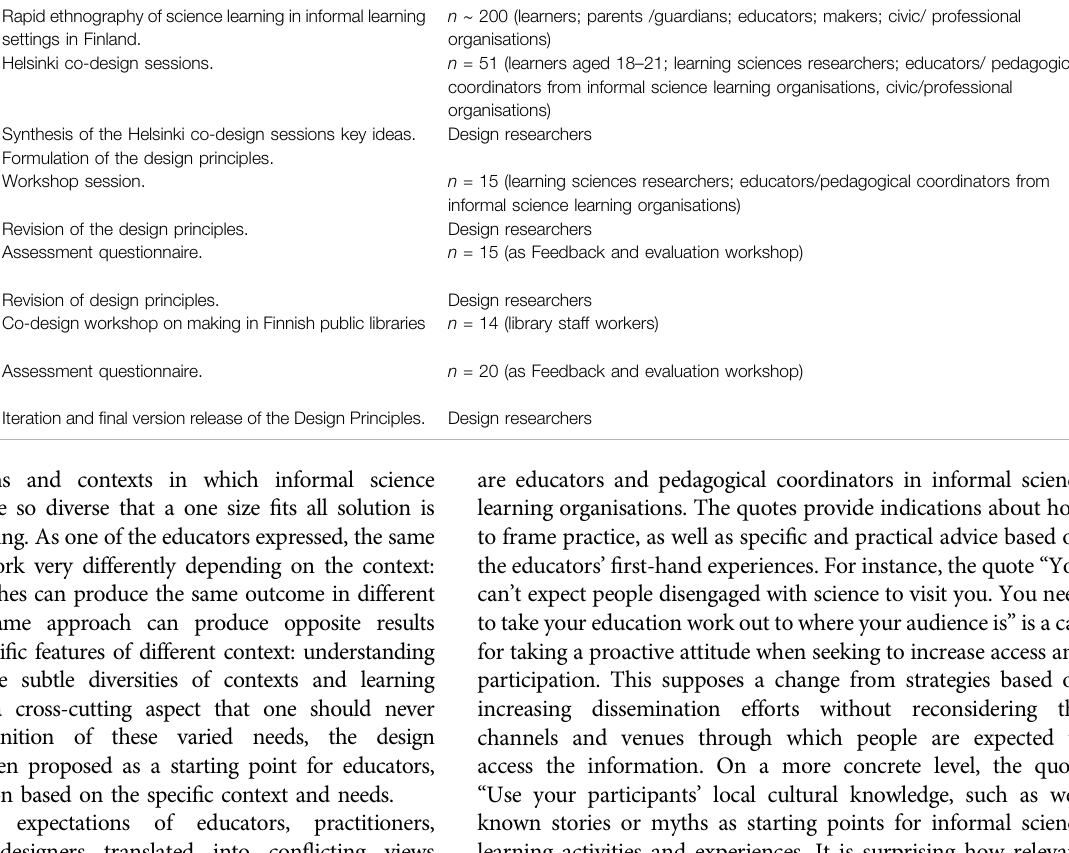
TABLE 1 | Summary of actions conducted during the SySTEM 2020 design inquiry.